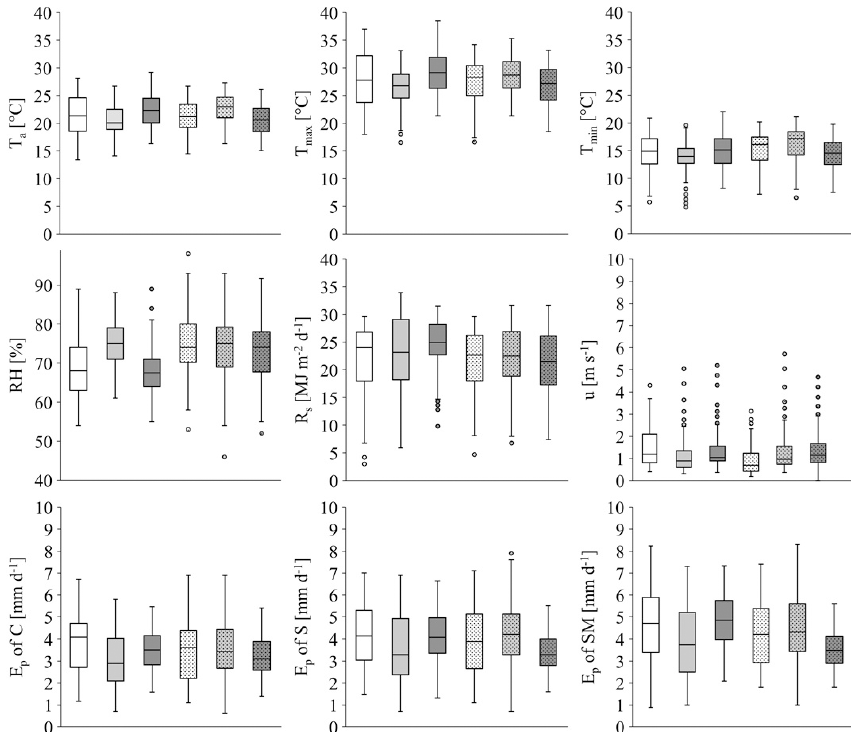
Figure 4. Box plot of meteorological parameters ( T a – daily mean temperature ( ◦ C), T max – daily maximum temperature ( ◦ C), T min – daily minimum temperature ( ◦ C), RH – relative humidity (%), R s – global radiation (MJm − 2 d − 1 ), u – wind speed (ms − 1 )), and daily evaporation of different pan treatments (mmd − 1 ) (C – control, S – class A pan with sediment cover bottom, SM – class A pan with submerged macrophyte) in 2015–2020 growing seasons (June–September). The lower and upper ends of the box indicate the 25th and 75th percentiles of the variances, respectively, while the horizontal bar within the box indicates the median. The two horizontal bars indicate the range that covers 90% of the variances. Outliers are indicated with